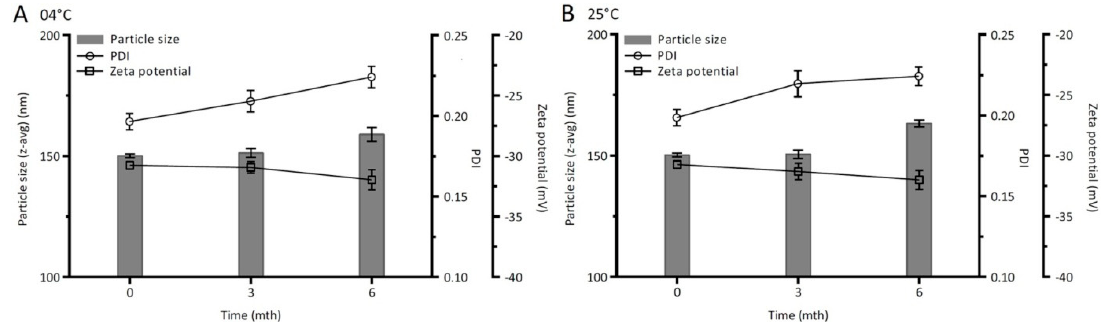
Figure 9. Particle size, PDI and zeta potential of optimized CLX-NC during six months of storage at different temperatures ( A : 4°C and B : 25°C) (mean ± SD, n = 3).